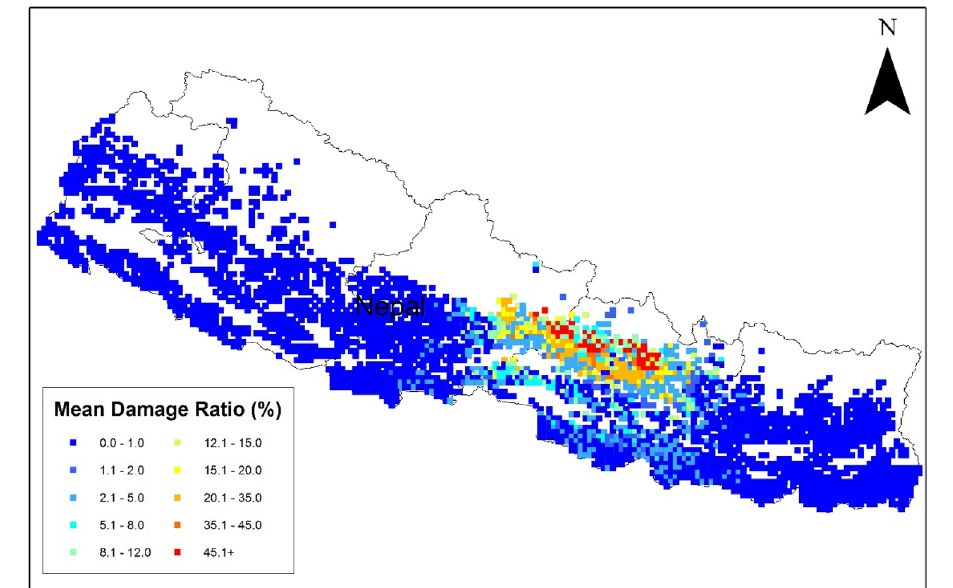
Fig. 4 MDR distribution for the residential buildings in